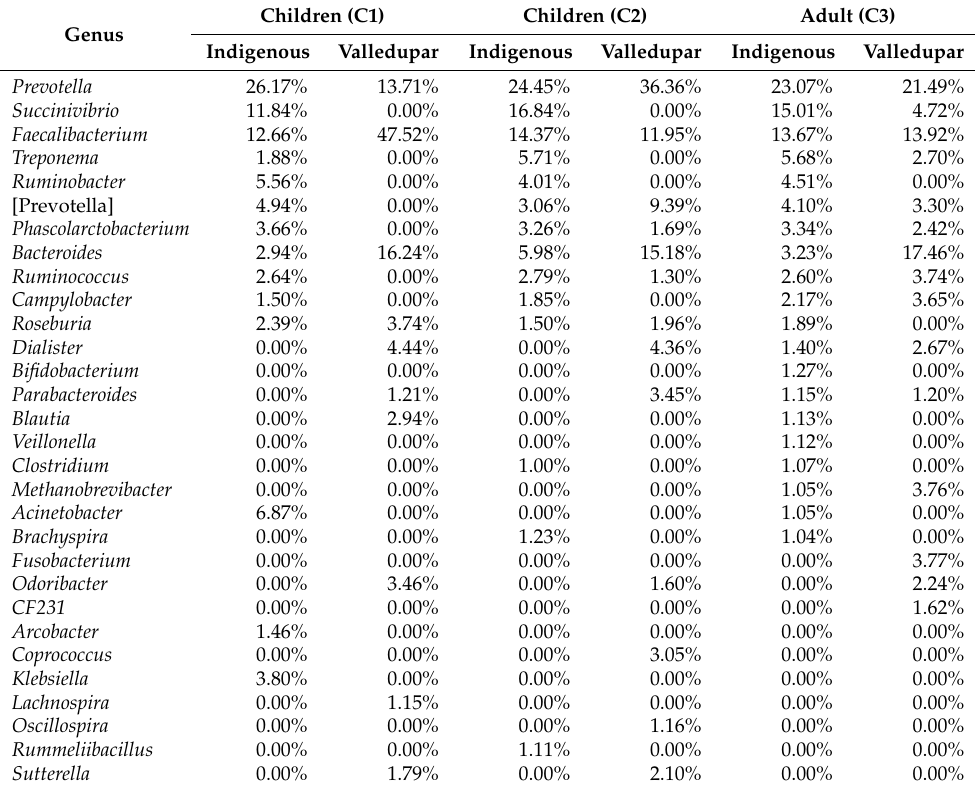
Table A7. Genera distribution for the gender groups in the Indigenous and Valledupar locations. Data indicate relative abundances (percentages of OTU counts). Genera with relative abundances lower than 1% were filtered out.